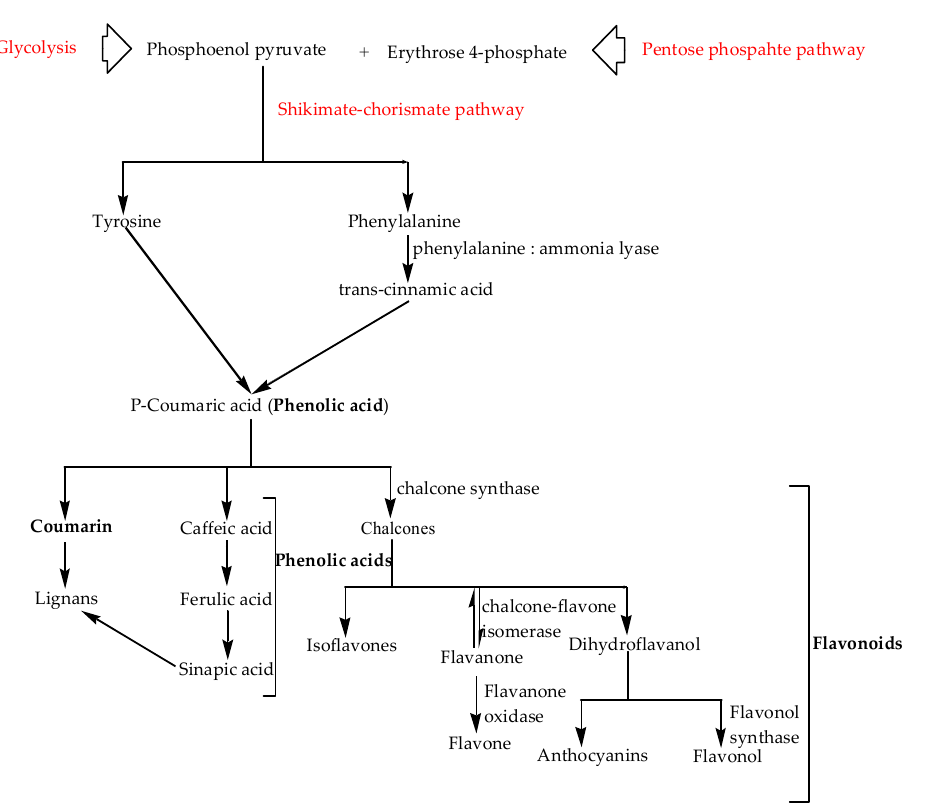
Figure 9. The generalised biosynthetic pathway of phenolic compounds.